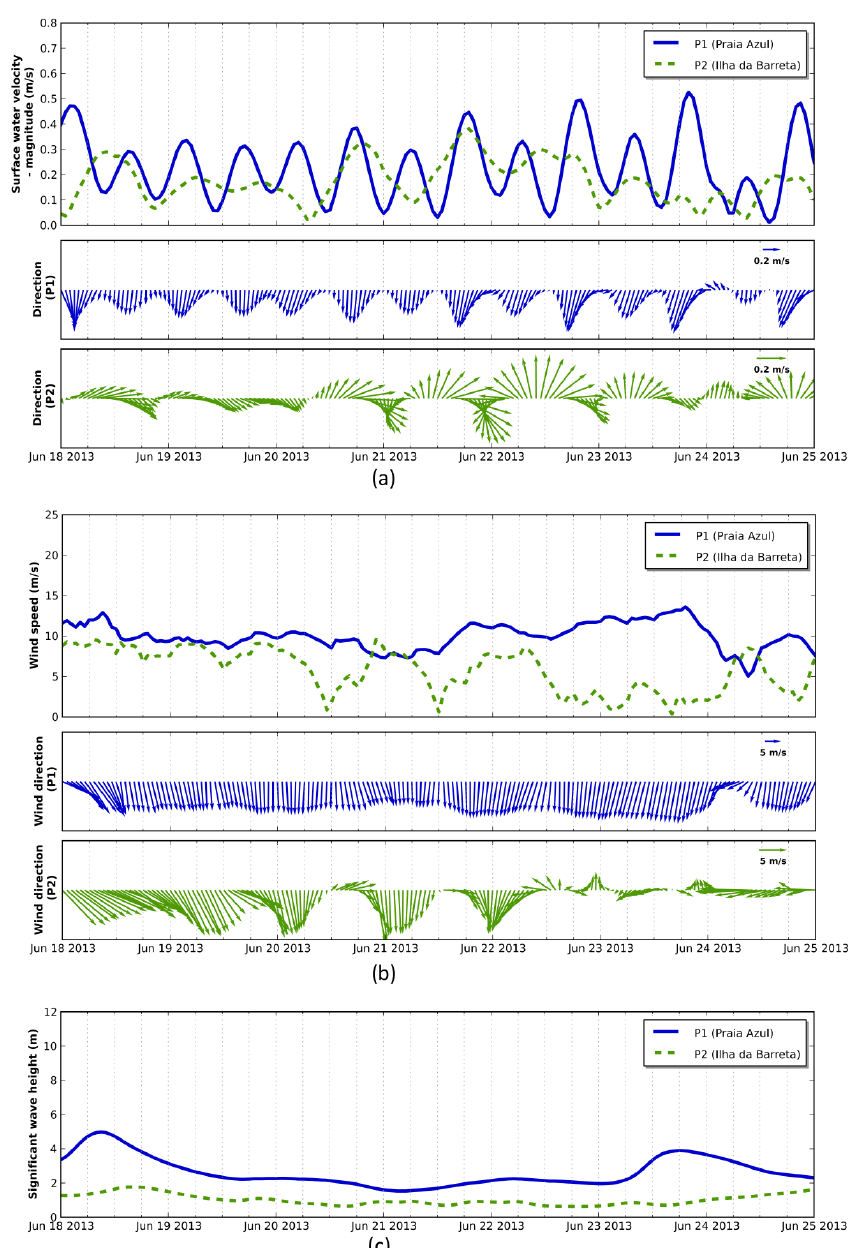
Figure 10. Metocean conditions used in the risk model, at points P 1 and P 2 , during June. Surface water velocity, wind velocity and significant wave